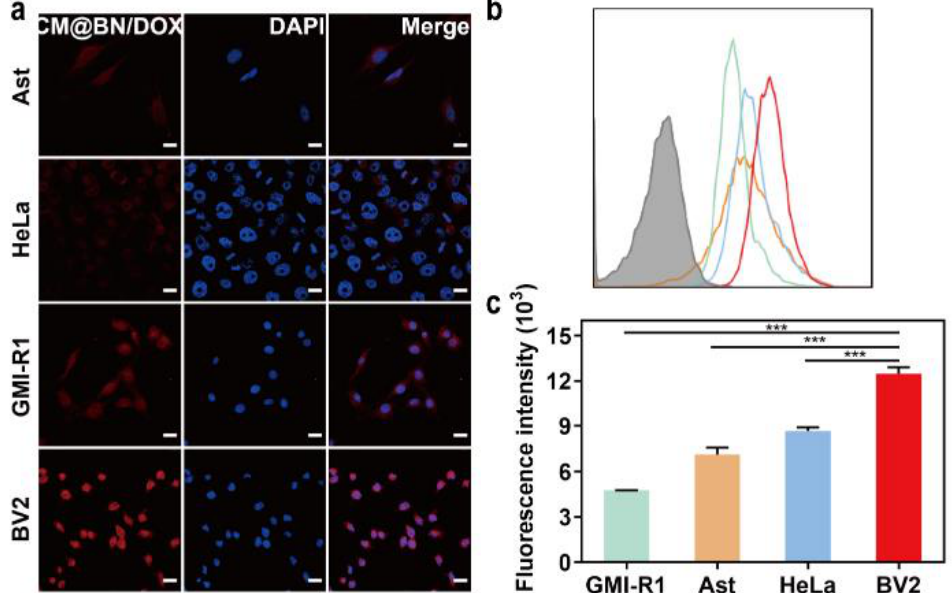
Figure 6. Homologous targeting of CM@BN/DOX. ( a ) Confocal laser scanning microscopy images of BV2, HeLa, GMI-R1, and Ast cells incubated with CM@BN/DOX for 2 h. Scale bar = 20 µm. ( b ) The intracellular uptake of CM@BN/DOX by BV2, HeLa, GMI-R1, and Ast cells using FCM (blank group was represented as grey). ( c ) Quantitative analysis. Data are presented as means ± SD, *** p < 0.001.